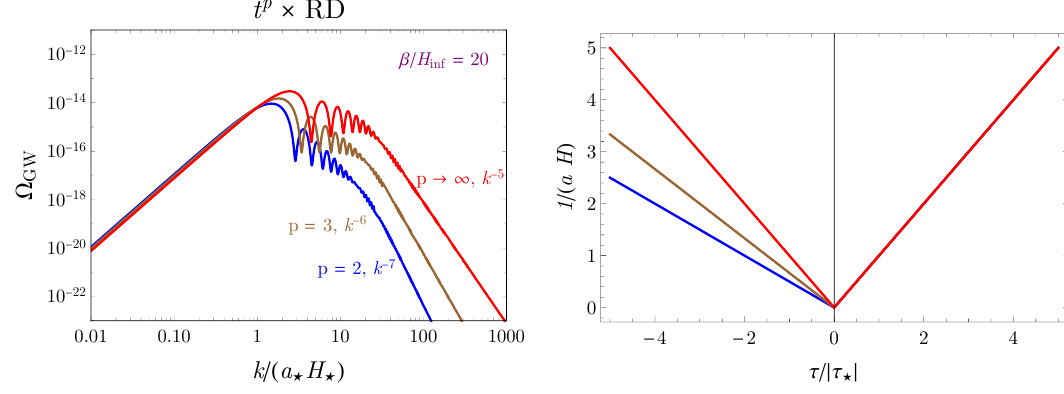
Figure 5 . The left panel shows the comparison of GW signal from quasi-de Sitter inflation (red) and t p inflation with p = 2 (blue). The right panel shows the corresponding co-moving horizon 1 / ( aH ) as a function of conformal time τ in these scenarios (with the same color legend). The three curves do not coincide in the region τ > 0 on the right panel but their difference is almost invisible from the plot. Both the UV and the oscillatory part of the GW spectrum in the three different scenarios are